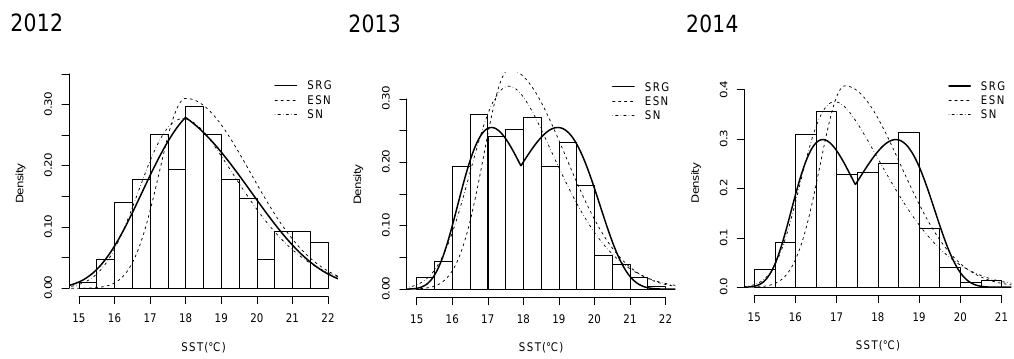
Figure 5. MLE fit of SRG, ESN and SN models for SST data by year.